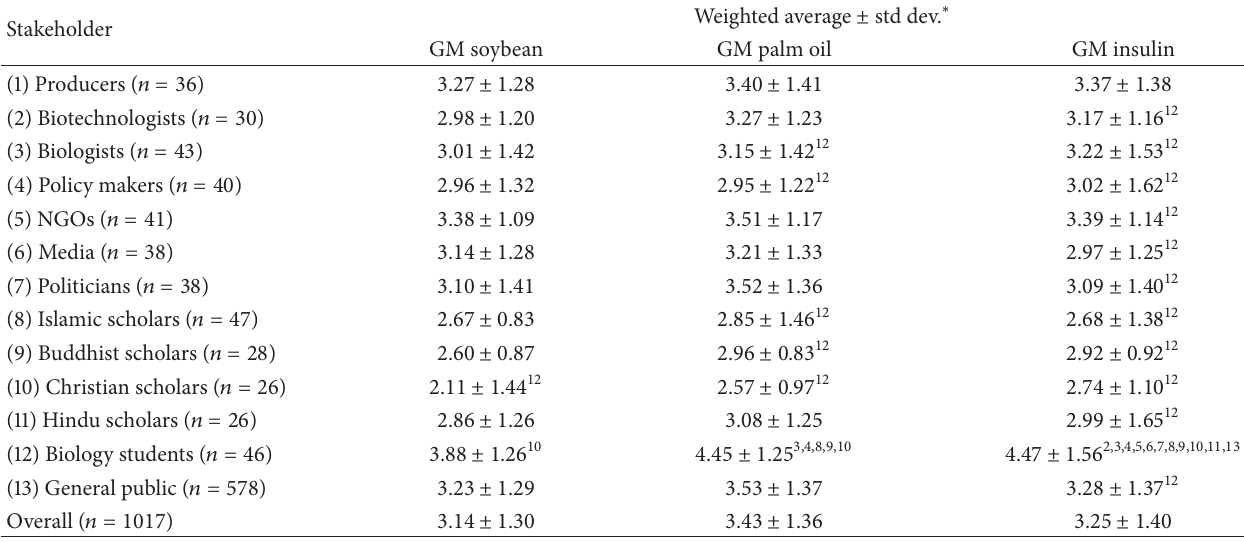
Table 4: Weighted average and post hoc test results for familiarity of GM foods and GM